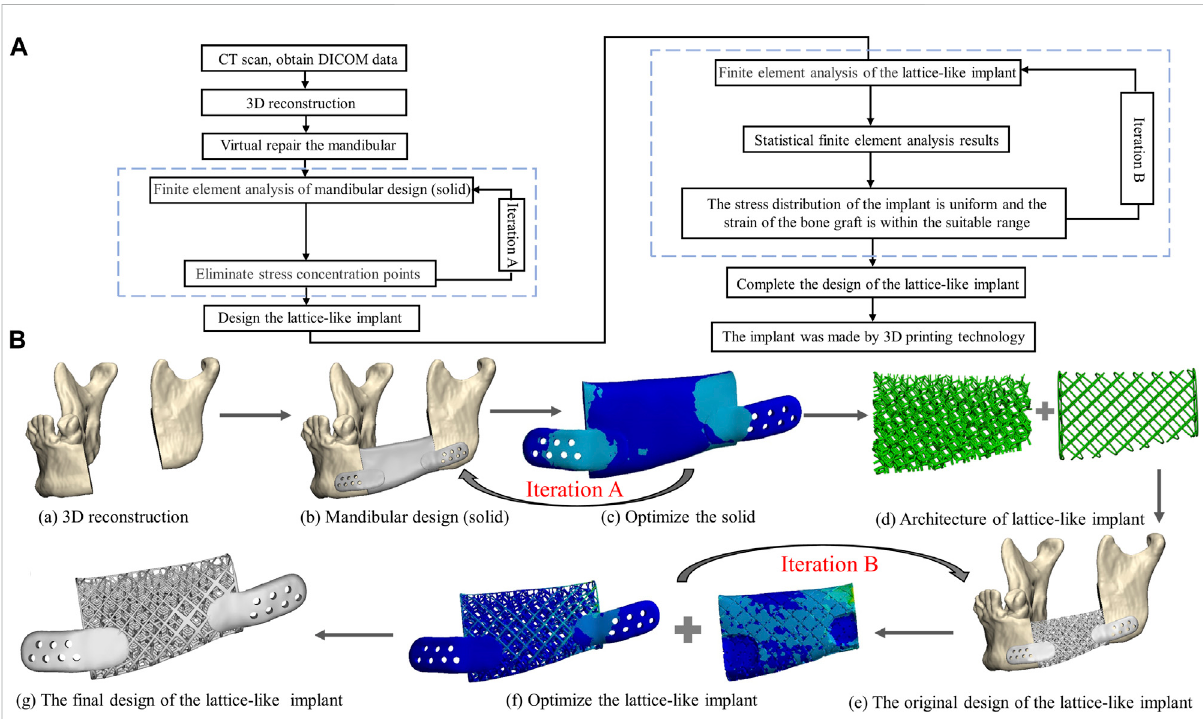
FIGURE 2 The framework from image acquisition to manufacturing implant. (A) Flowchart of lattice-like implant design, optimization and manufacture. (B) Schematic diagramoflattice-likeimplantdesign,optimizationandmanufacture. (a)3Dreconstruction.(b)Mandibular design (solid).(c)Optimize thesolidcounterpart.(d)Thearchitectureoflattice-likeimplant.(e)Theoriginaldesignofthelattice-likeimplant.(f)Optimizethelattice-likeimplant. (g) The fi nal design of the 3D implant.